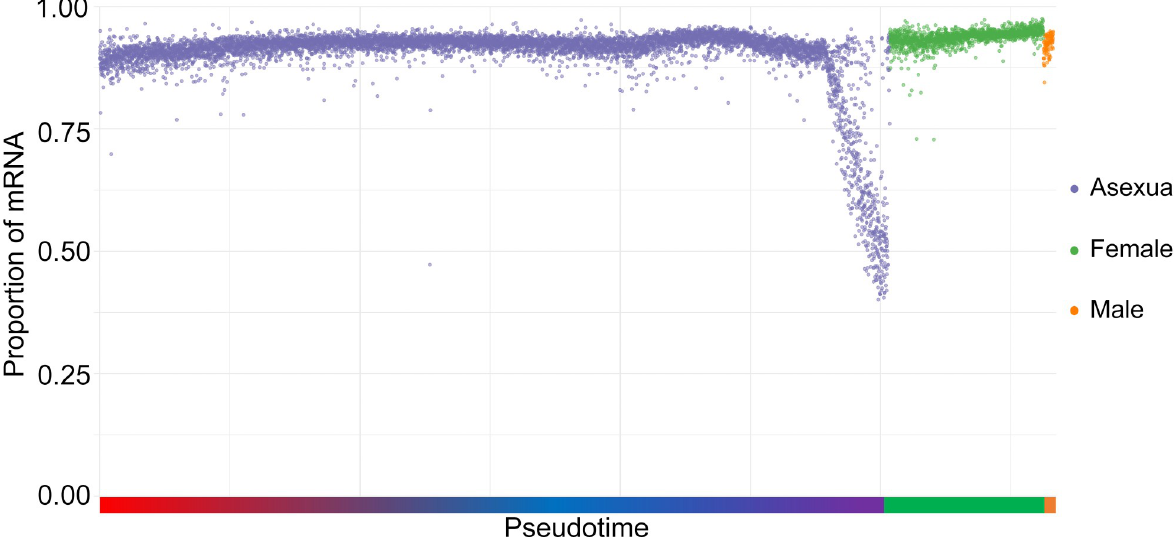
Fig 5. Proportion of mRNA transcribed from P . vivax genes with a P . falciparum orthologs. The figure shows the proportion of the mRNA molecules derived from P . vivax genes with at least one P . falciparum ortholog (y-axis) according to the parasite developmental stage (x-axis). Blue dots indicate asexual parasites organized according to their developmental pseudotime rank (from trophozoites on the left to schizonts on the right); green dots represent female gametocytes and orange dots male gametocytes. Underlying data are provided in S5 Data.